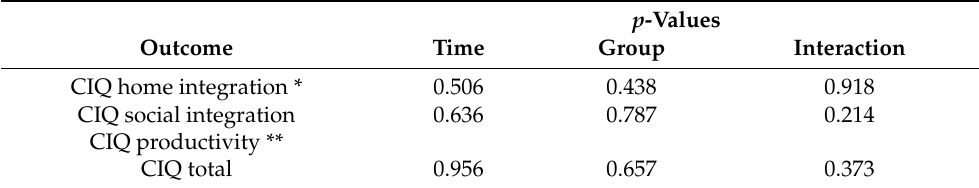
Table 4. Mixed ANOVA results examining changes in community integration from baseline to completion between groups.